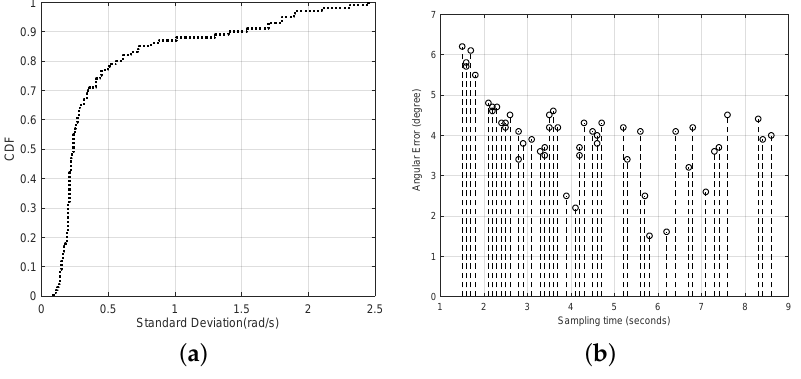
Figure 14. ( a ) the CDF of the standard deviation of the angular velocity; and ( b ) the angular errors of different sampling times.